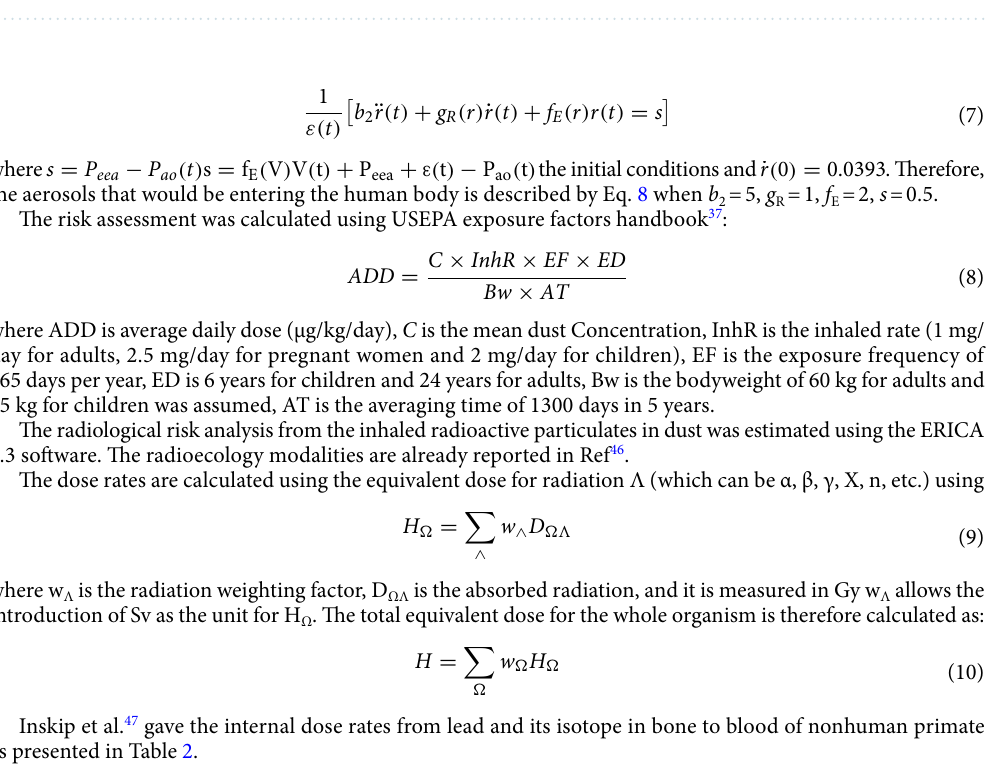
Table 2. Lead and its isotope influence in the human body 47